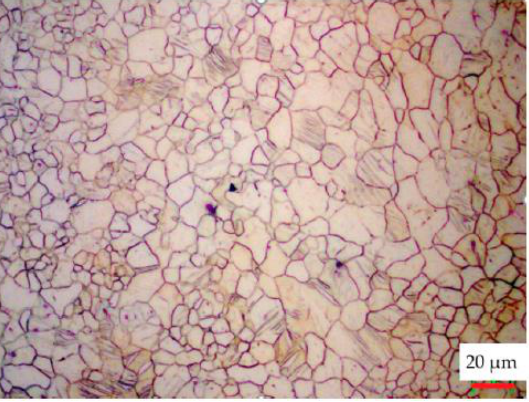
Figure 1. Microscope image of pure magnesium microstructure quenched in liquid CO 2 at 500×.